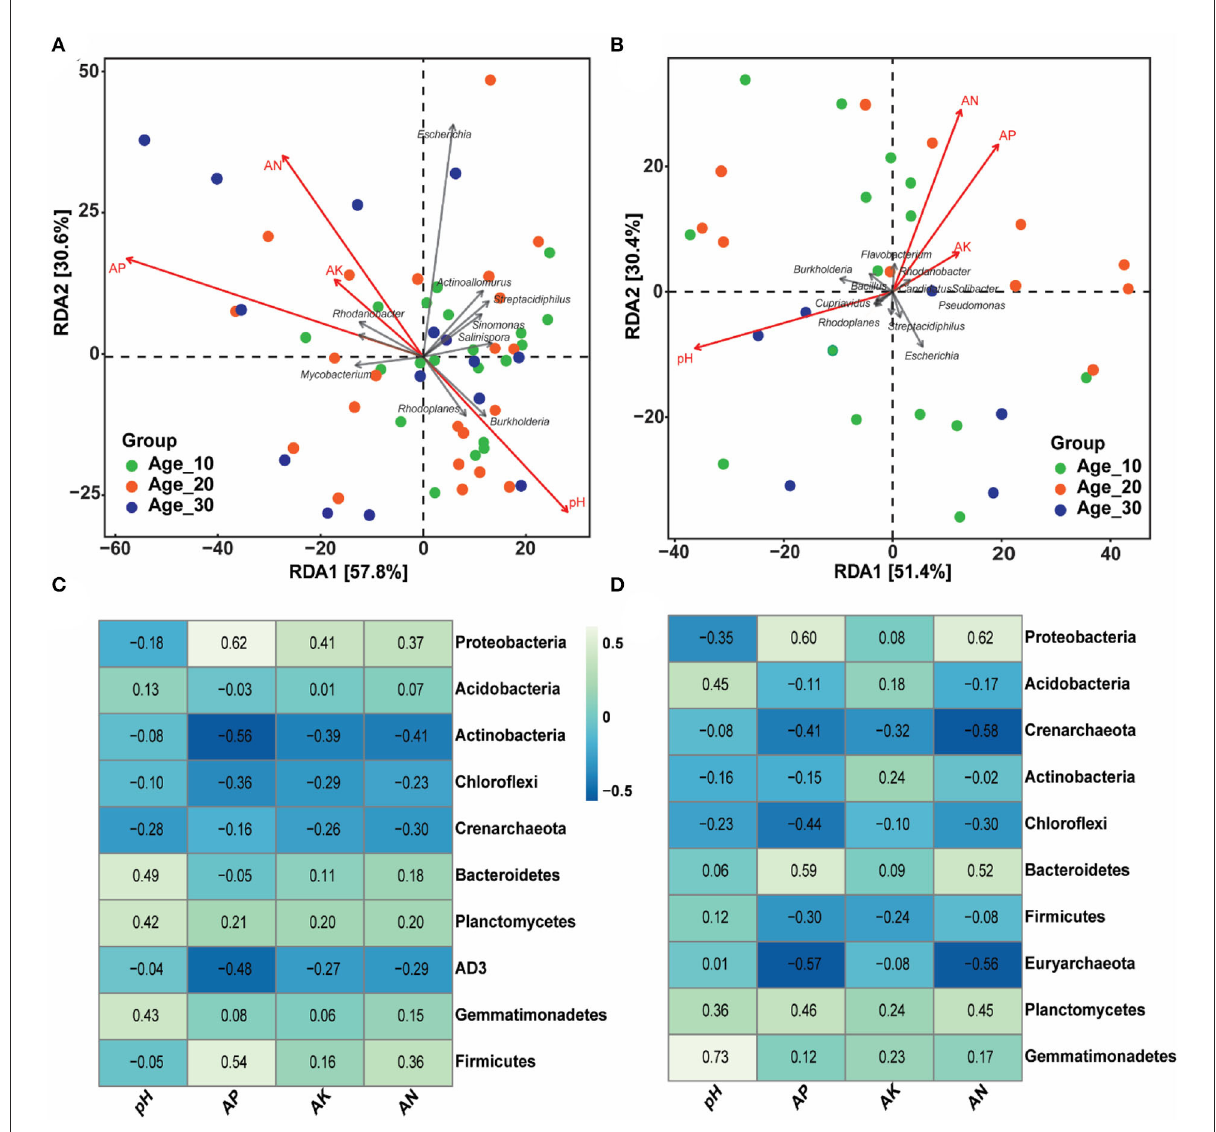
FIGURE5 Influence of soil physicochemical characteristics on bacterial community. (A,B) Community–environment relationship using the RDA ordination plot of bacterial communities in red and paddy soils, respectively. (C,D) Heatmap showing the strength of correlation between the soil properties and bacterial community for red and paddy soils, respectively. Here, Age_10, Age_20, and Age_30 denote the different pomelo tree ages of 10, 20, and 30 years,